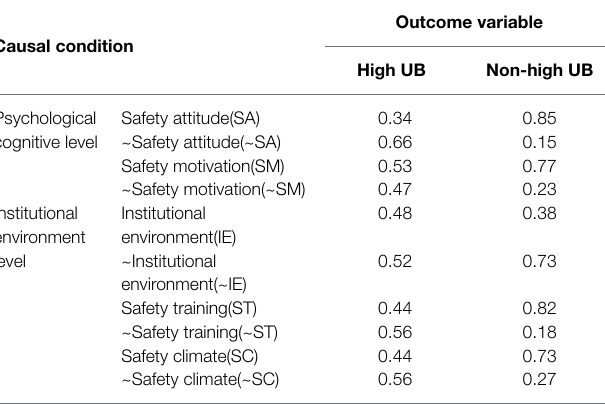
TABLE 8 | Necessity analysis of single Causal